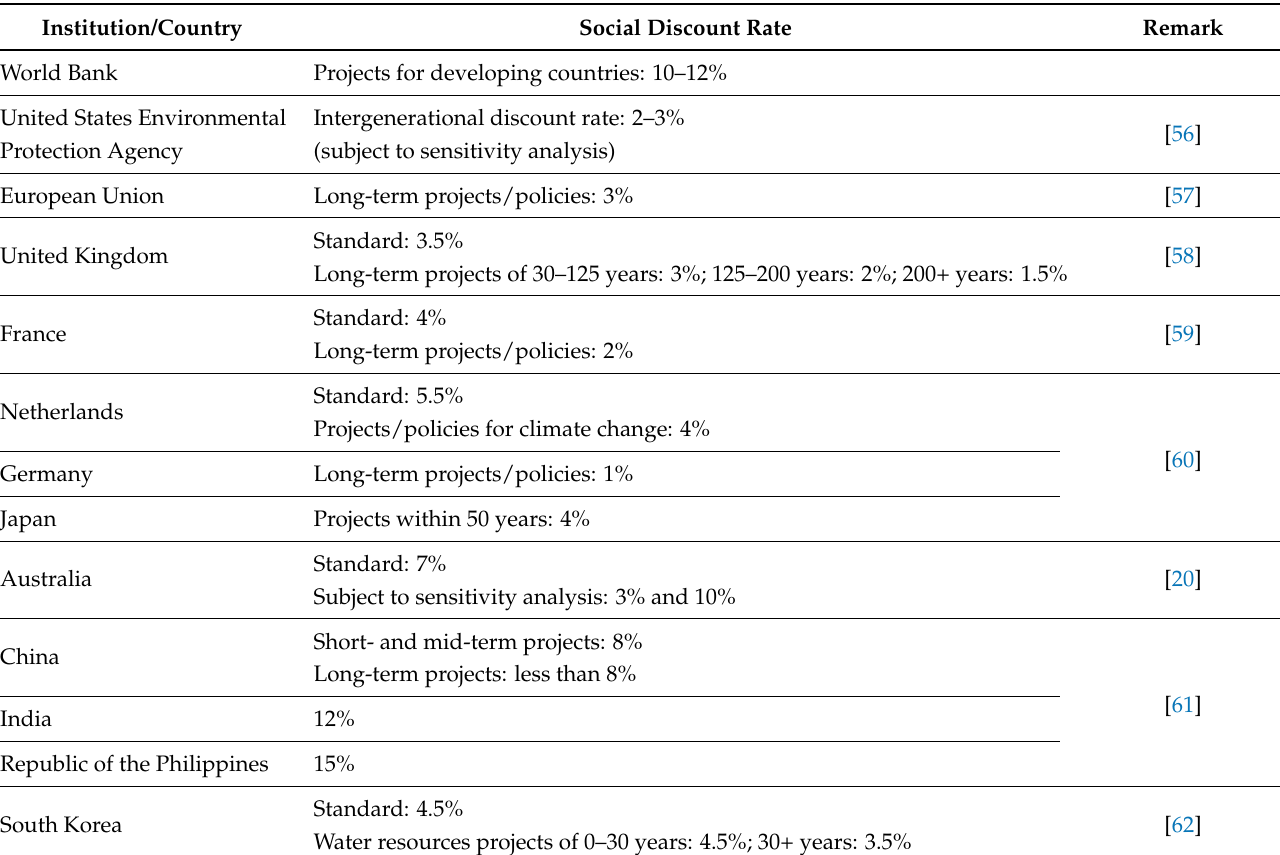
Table A1. Estimates for social discount rates in countries across the world.